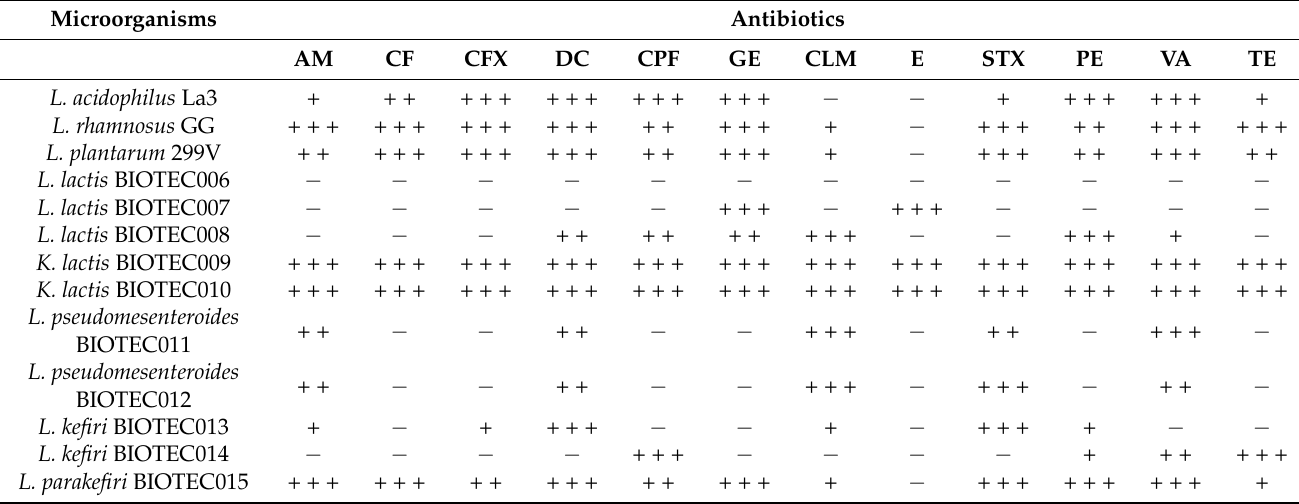
Table 4. Antibiotic resistance of the identified kefir isolates and commercial probiotics. Microorganisms Antibiotics